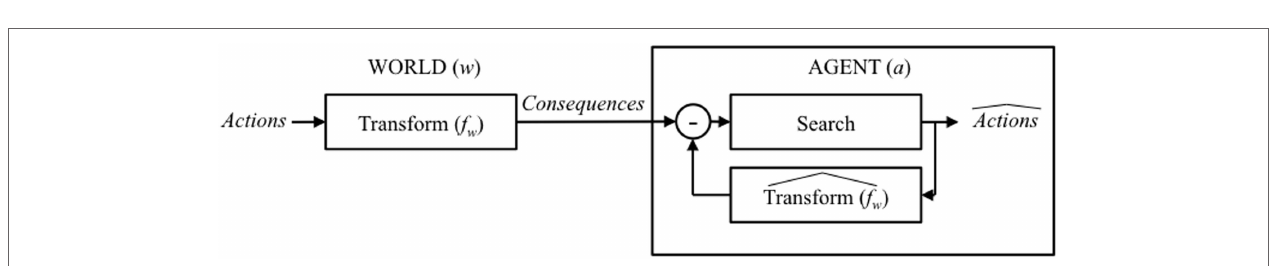
FIGURE 6 | Illustration of an agent a attempting to infer the hidden causes/actions from their observable effects/consequences by using a negative feedback-control loop to search the outputs from b f w (a forward estimate of f w ).